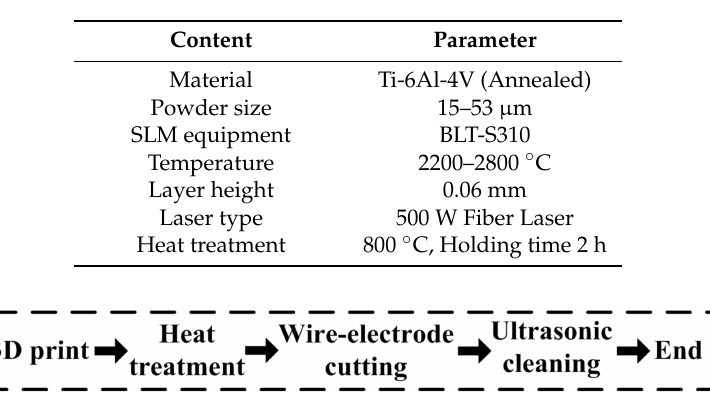
Table 2. Related introduction for additive manufacturing.